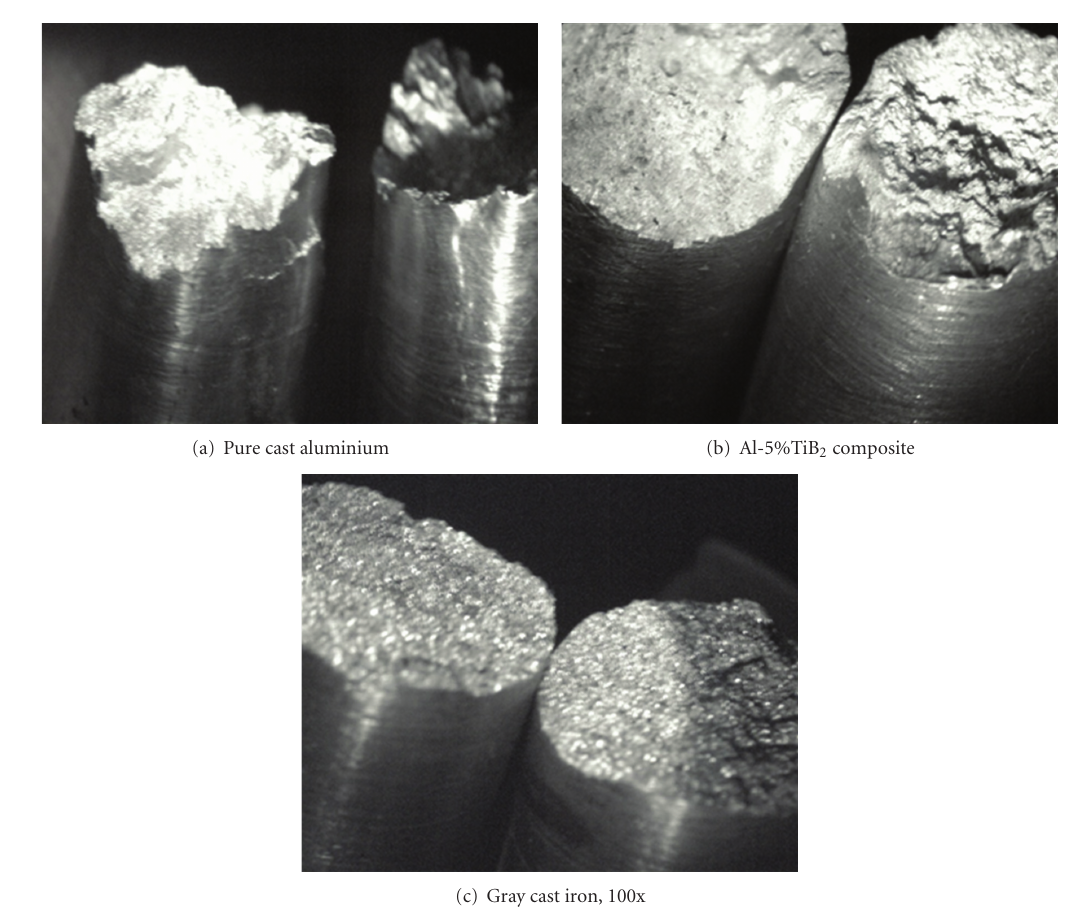
Figure 8: Stereomicrographs of tensile fractured surfaces of (a) Cast aluminium, (b) Al-5%TiB 2 composite and (c) Gray cast iron.